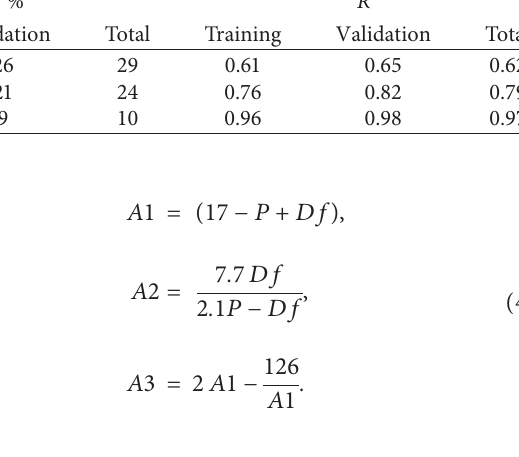
Table 5: Summary for the performance accuracy of formulas generated using (GP). Trial